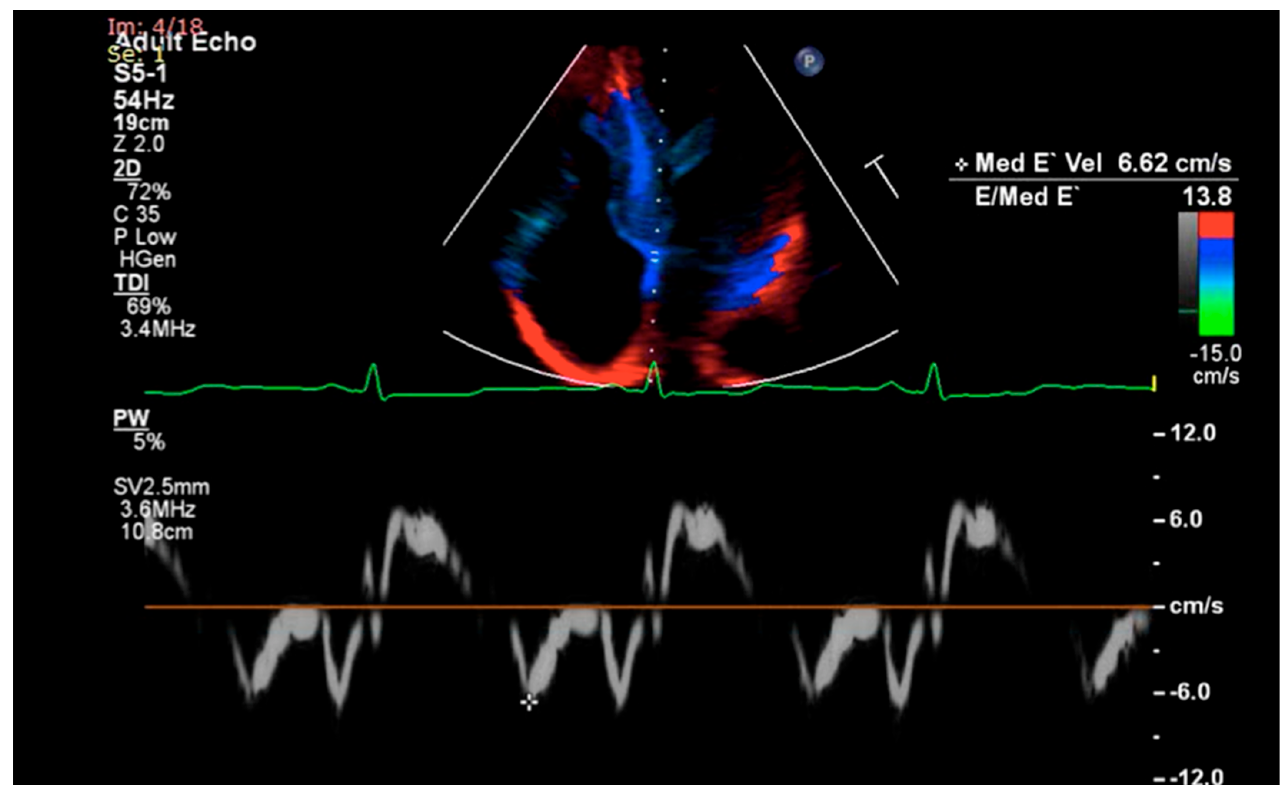
Figure 1. Tissue Doppler imaging demonstrating decreased septal e’ velocity and increased E/e’ ratio in a female with cardiac amyloidosis.